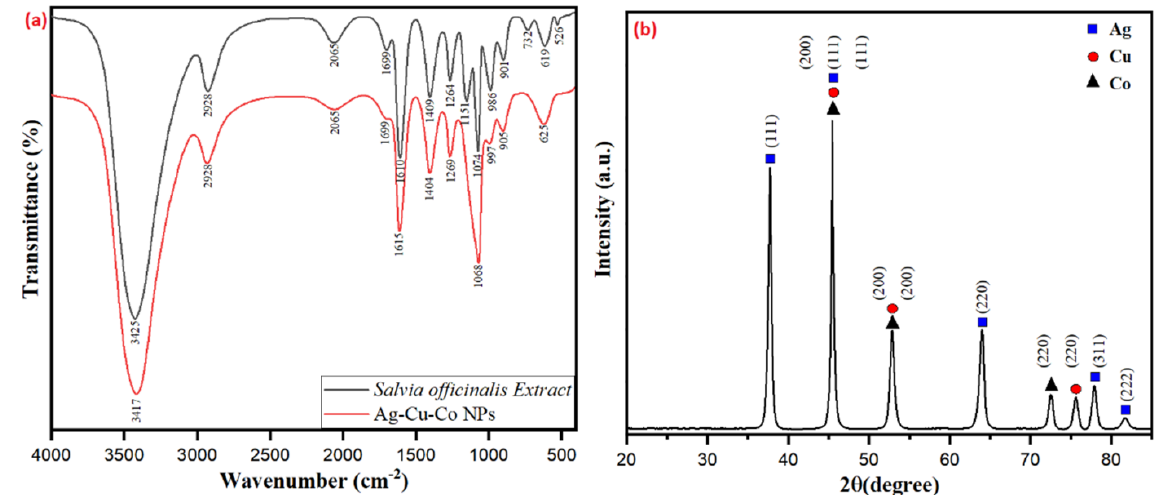
Figure 2. ( a ) Fourier transform infrared (FTIR) spectra of Salvia officinalis assisted Ag-Cu-Co trimetallic nanoparticles. ( b ) The X-ray diffraction (XRD) patterns of Salvia officinalis assisted Ag-Cu-Co trimetallic nanoparticles. Table 1. The X-ray diffraction peak data of Ag-Cu-Co trimetallic nanoparticles. S. No.